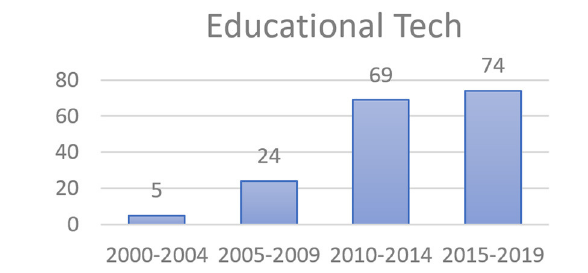
technology ( Figure 4 ) due to the release of the Framework for K-12 Science Education in 2011 and NGSS in